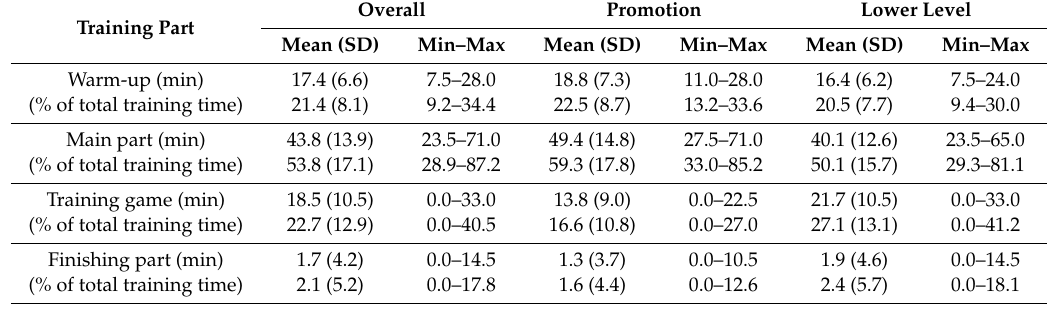
Table 3. Mean duration of training parts during training sessions. Data presented as means with standard deviation and minimum and maximum.